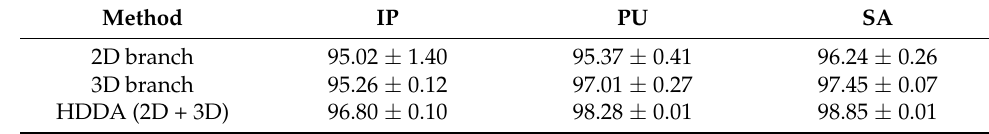
Table 11. Comparison of OA using three network structures for the three datasets.